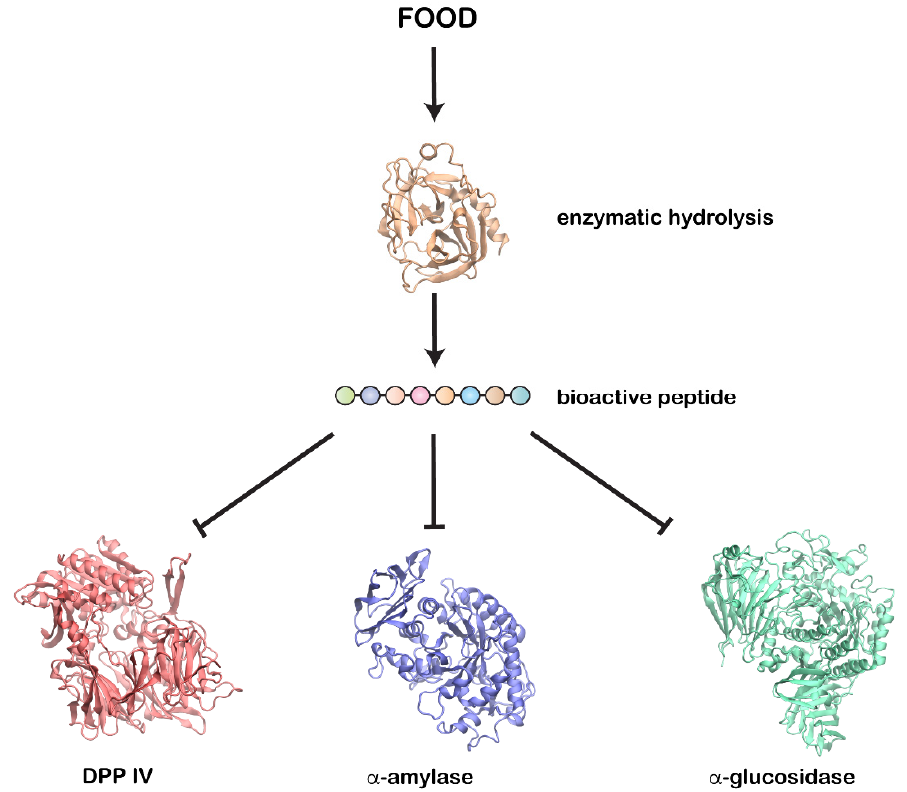
Figure 1. Enzymatic hydrolysis of food proteins produces bioactive peptides that could inhibit key enzymes involved in diabetes—DPP IV, α -amylase, and α -glucosidase. enzymes involved in diabetes—DPP IV, α -amylase, and α